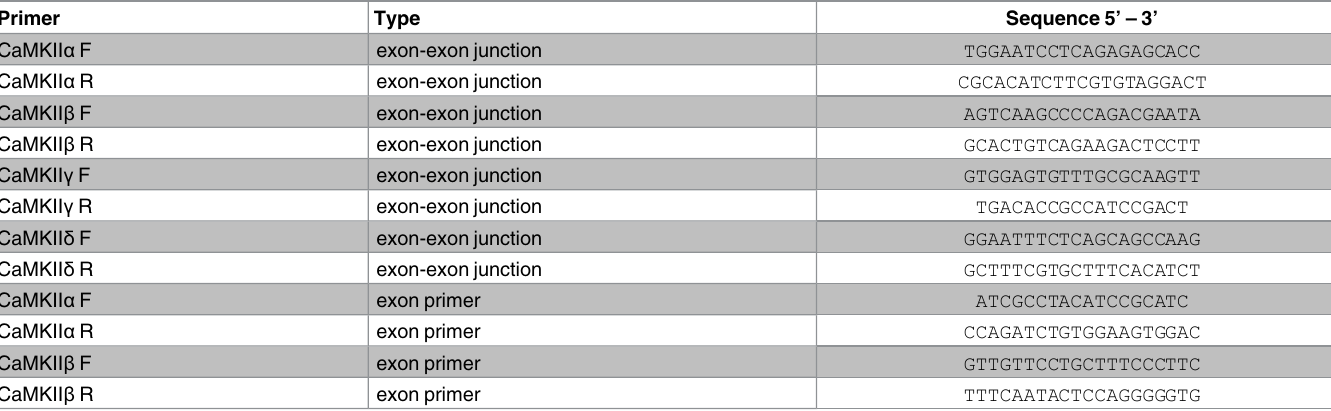
Table 2. RT-PCR primers used for CaMKII isoform analysis.